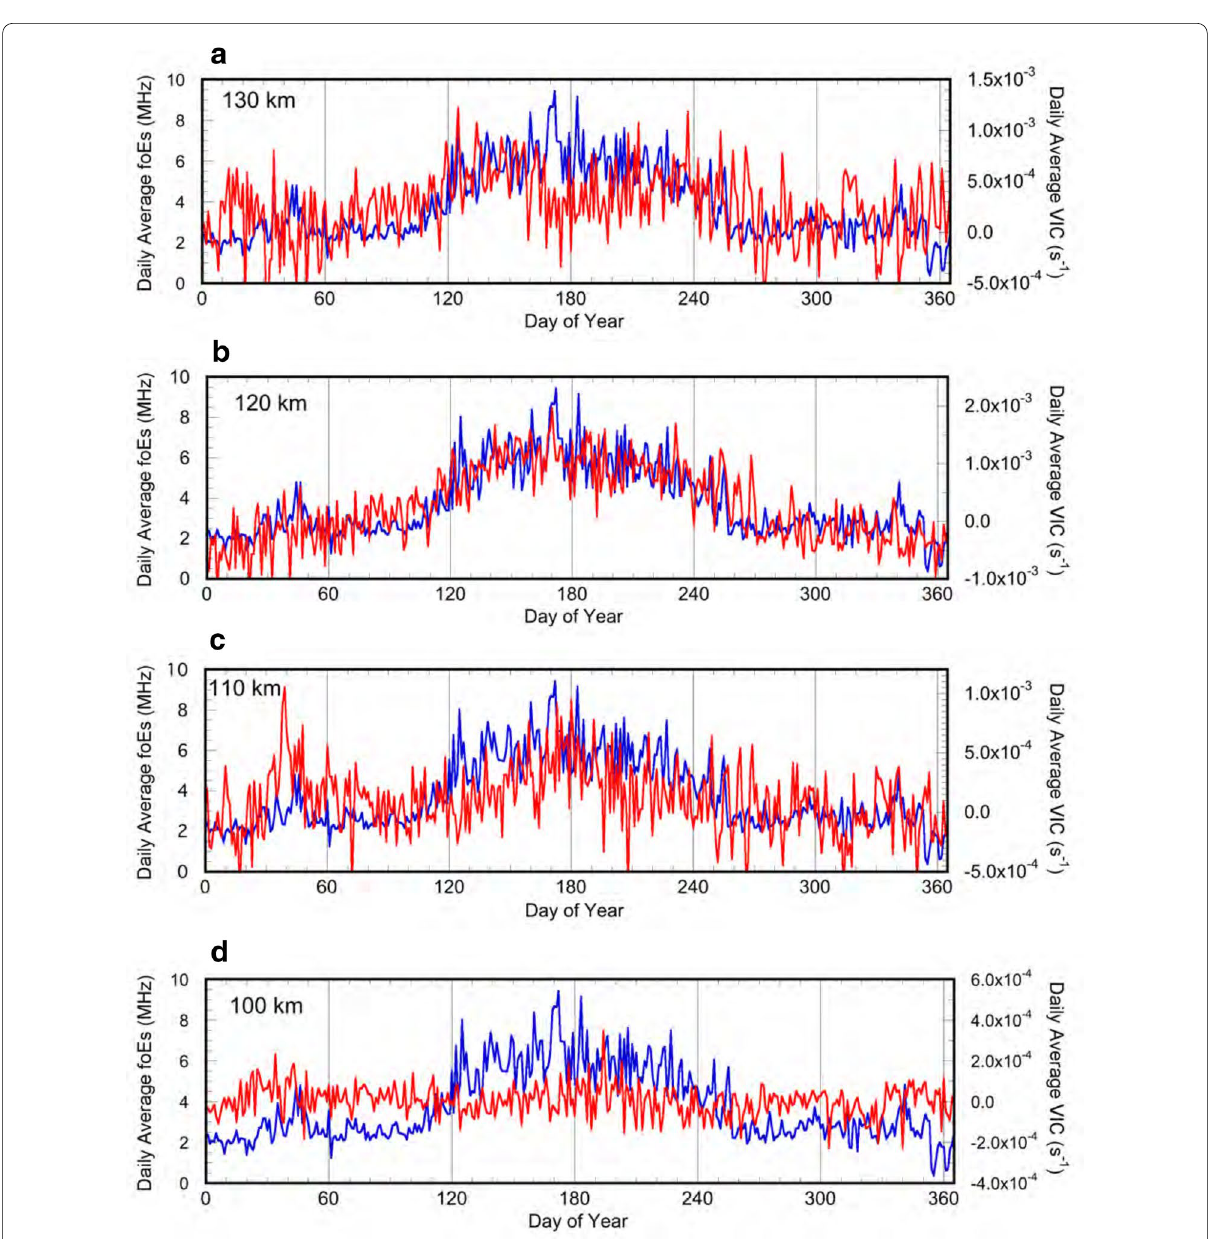
Fig. 2 Daily average foEs and daily average vertical ion convergence. Daily average foEs (blue line) and daily average vertical ion convergence ( VIC ) (red line) at Kokubunji in 2009 are compared at four different altitudes: a 130 km, b 120 km, c 110 km, and d 100 km. The scales on the daily average VIC are adjusted so that the values are best fitted to the foEs